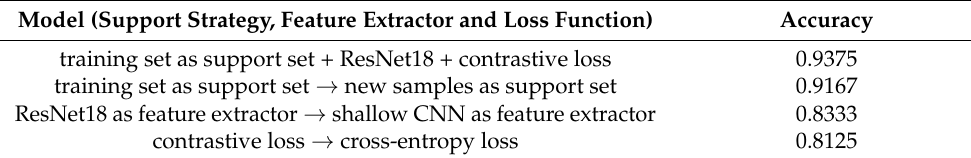
Table 2. Results of substitution comparison of major elements in the model.